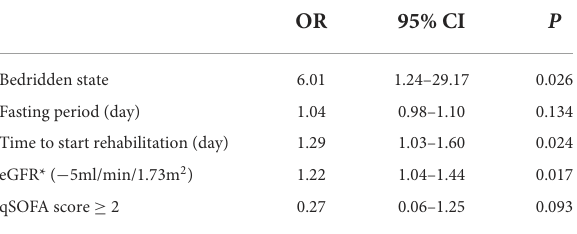
TABLE 3 Analysis of factors associated with longer LOSs in multivariate